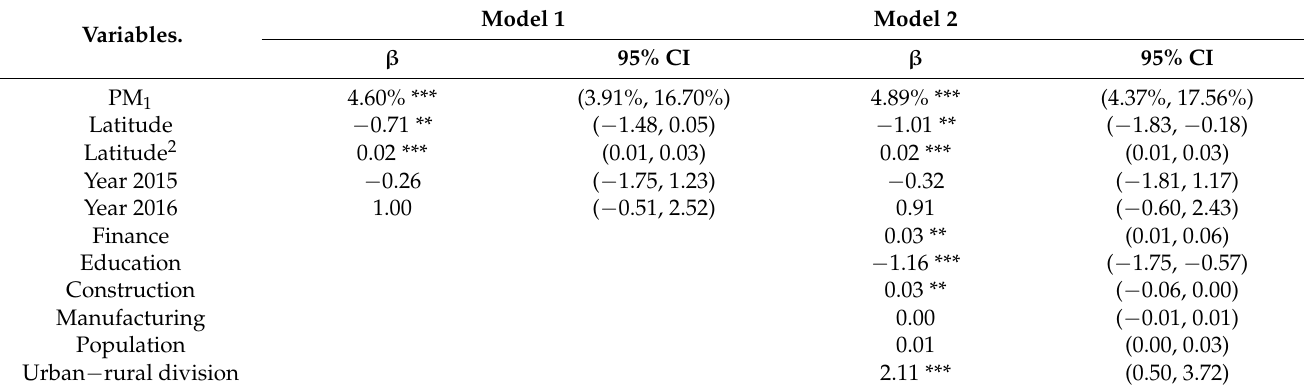
Table 3. PM 1 and the incidence rate of female lung cancer: associations in the two